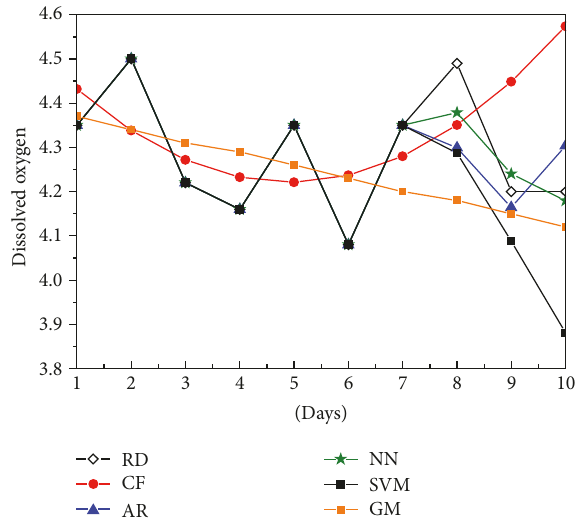
Figure 3: The actual value and predicted value for the second pond.